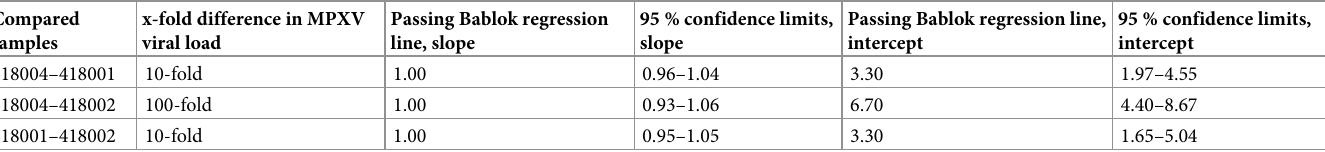
Table 5. Results of the Passing Bablok fit for the MPXV Ct/Cq results. Compared samples